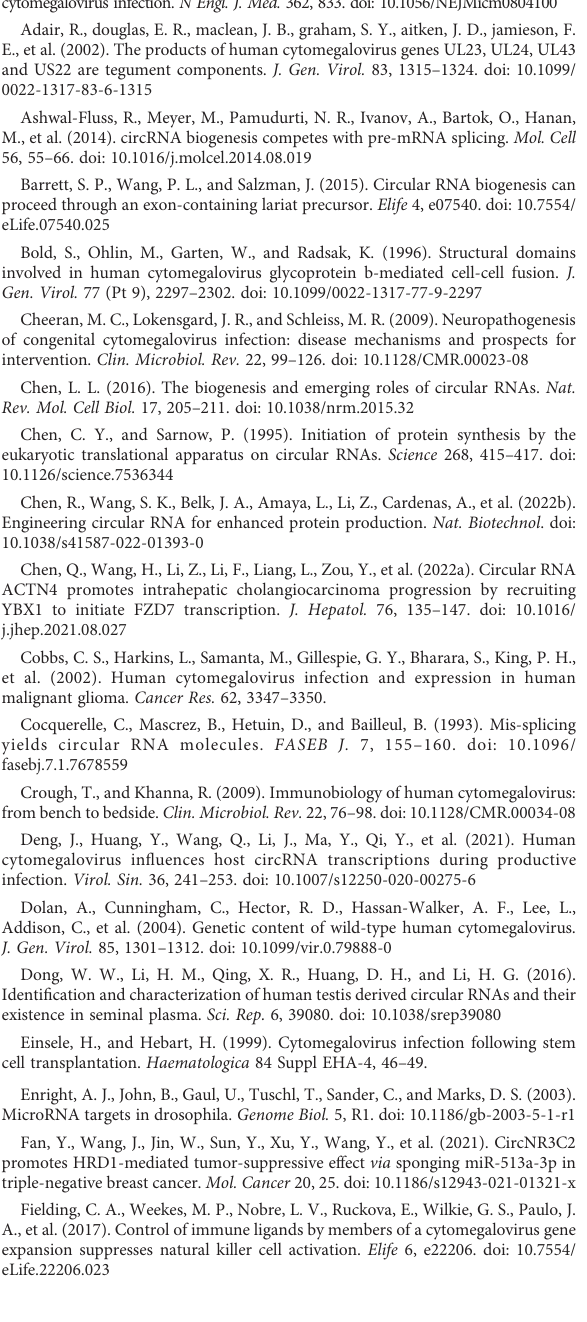
SUPPLEMENTARY FIGURE 1 Morphology of mock-treated and HCMV-infected HELFs. HELFs were infected with HCMV at a multiplicity of infection (MOI) of 3. After 24 hours ofincubation,theculturemediumwasreplacedwithMEMcontaining2%FBS, 100 units/mL penicillin, and 100 m g/mL streptomycin. Meantime, PBS-treated HELFs were prepared as a mock-infected control. The HCMV-infected and mock-infected HELFs were harvested at 72 hours post infection